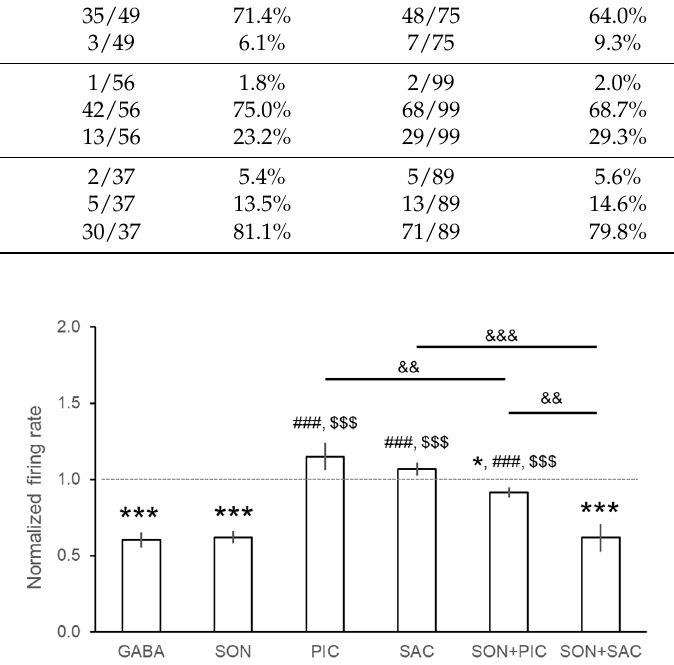
Figure 2. Effects of various treatments on neuronal firing activity. Injections of GABA or SON inhibited neuronal firing activity, while injections of PIC or SAC did not change the firing rate. The GABA(A) antagonist PIC was able to attenuate the inhibitory effects of SON. However, the GABA(B) antagonist SAC did not influence the modulatory effects of SON (one-way ANOVA: F(5, 427) = 17.256, p < 0.001). Notation of significant differences are as follows: one-sample t -test: * p < 0.05, *** p <